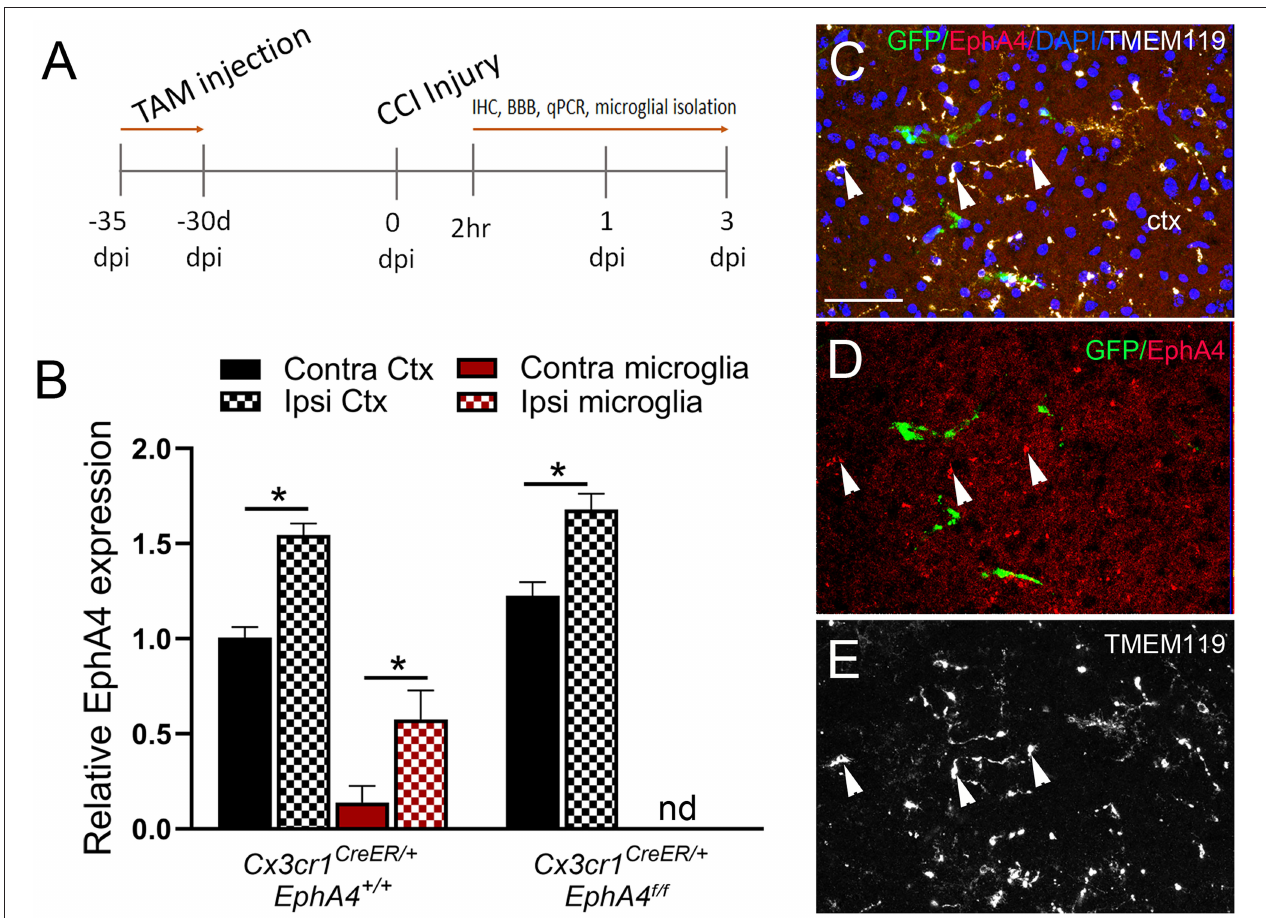
FIGURE 4 | EphA4 expression in microglia at 2h post-CCI injury. (A) Cx3cr1 CreER / creER EphA4 + / + , Cx3cr1 CreER / + EphA4 + / + , and Cx3cr1 CreER / + EphA4 f / f mice were intraperitoneally injected with five daily doses of tamoxifen (100 mg/kg) and then subjected to CCI injury 30 days after the last injection. Microglia were isolated from ipsilateral and contralateral cortices for qRT-PCR analysis at 2h. (B) Relative EphA4 mRNA expression was measured in isolated microglia and non-adherent cells from ipsilateral (ipsi) and contralateral (contra) cortices (Ctx) at 2h. N = 5, * p < 0.05, significant difference between the designated groups; nd, not detected. (C–E) Representative confocal images for IHC analysis of TMEM119 (white) and EphA4 (red) in GFP bone marrow chimeric WT mice, showing increased EphA4 expression in resident microglia (white arrowhead, EphA4 + GFP − TMEM119 + ). Scale bar = 100 µ